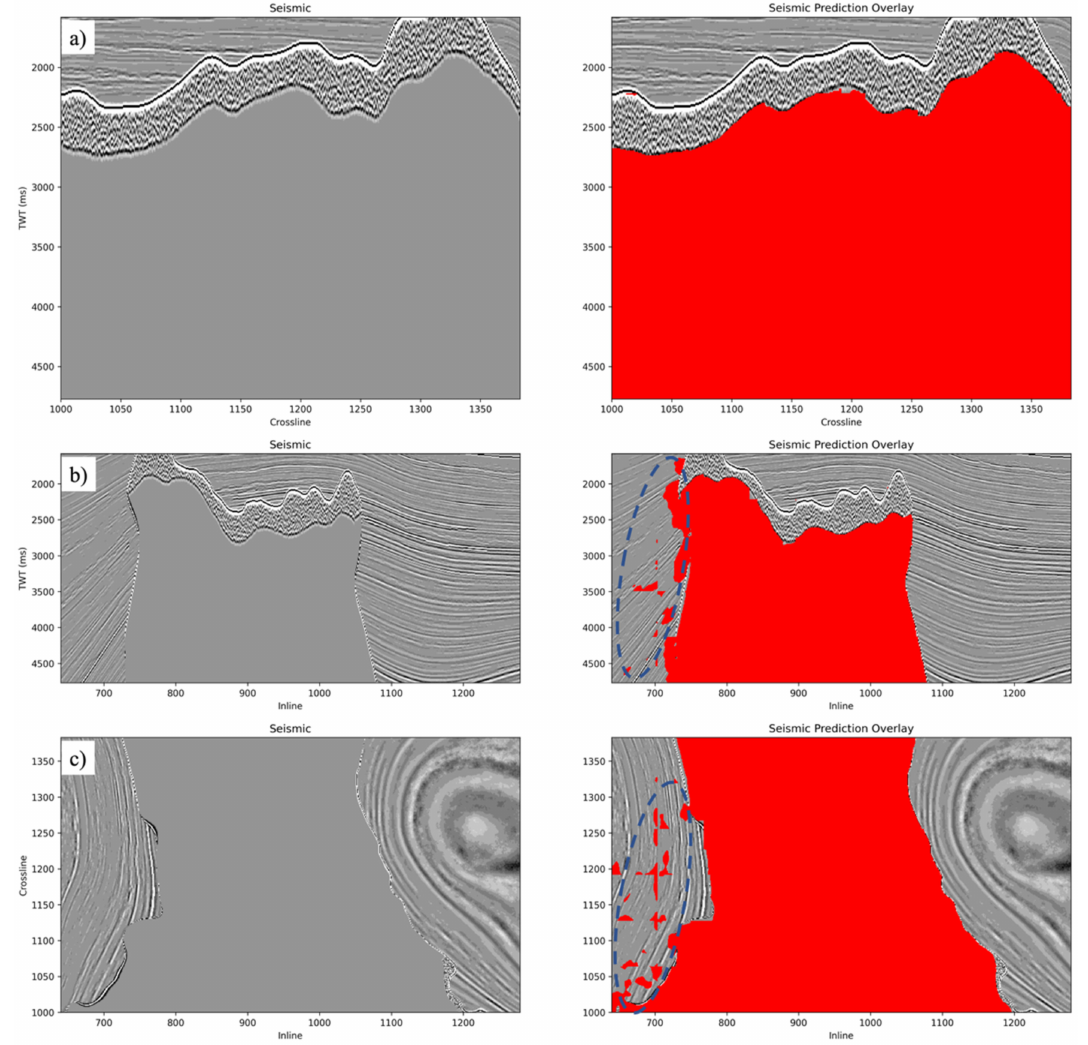
Figure 17. The predicted result of salt features on ( a ) inline, ( b ) crossline, and ( c ) time-slice seismic